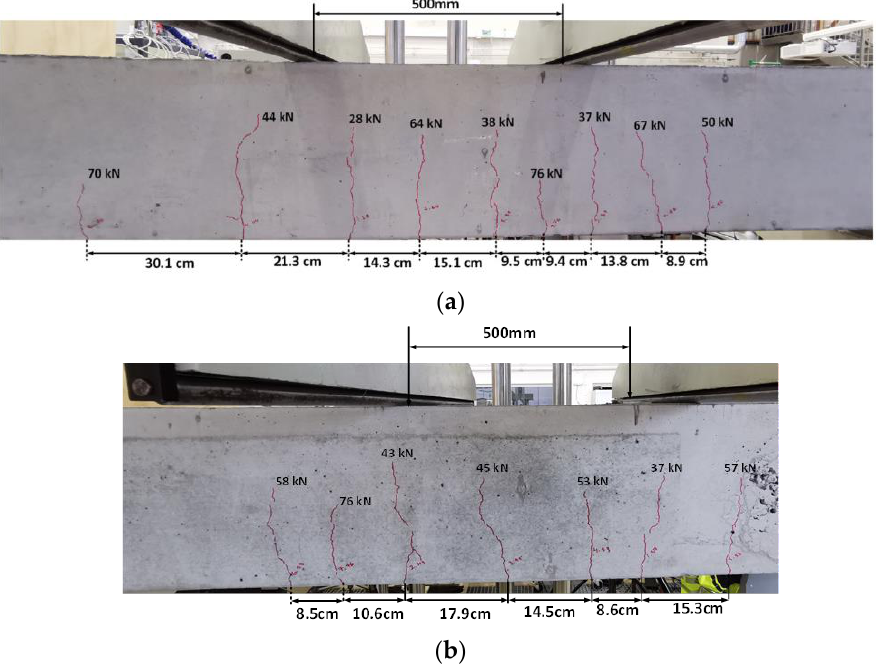
Figure 7. ( a ) Beam B.70 (70% of Py). ( b ). Beam A.70 (70% of Py).